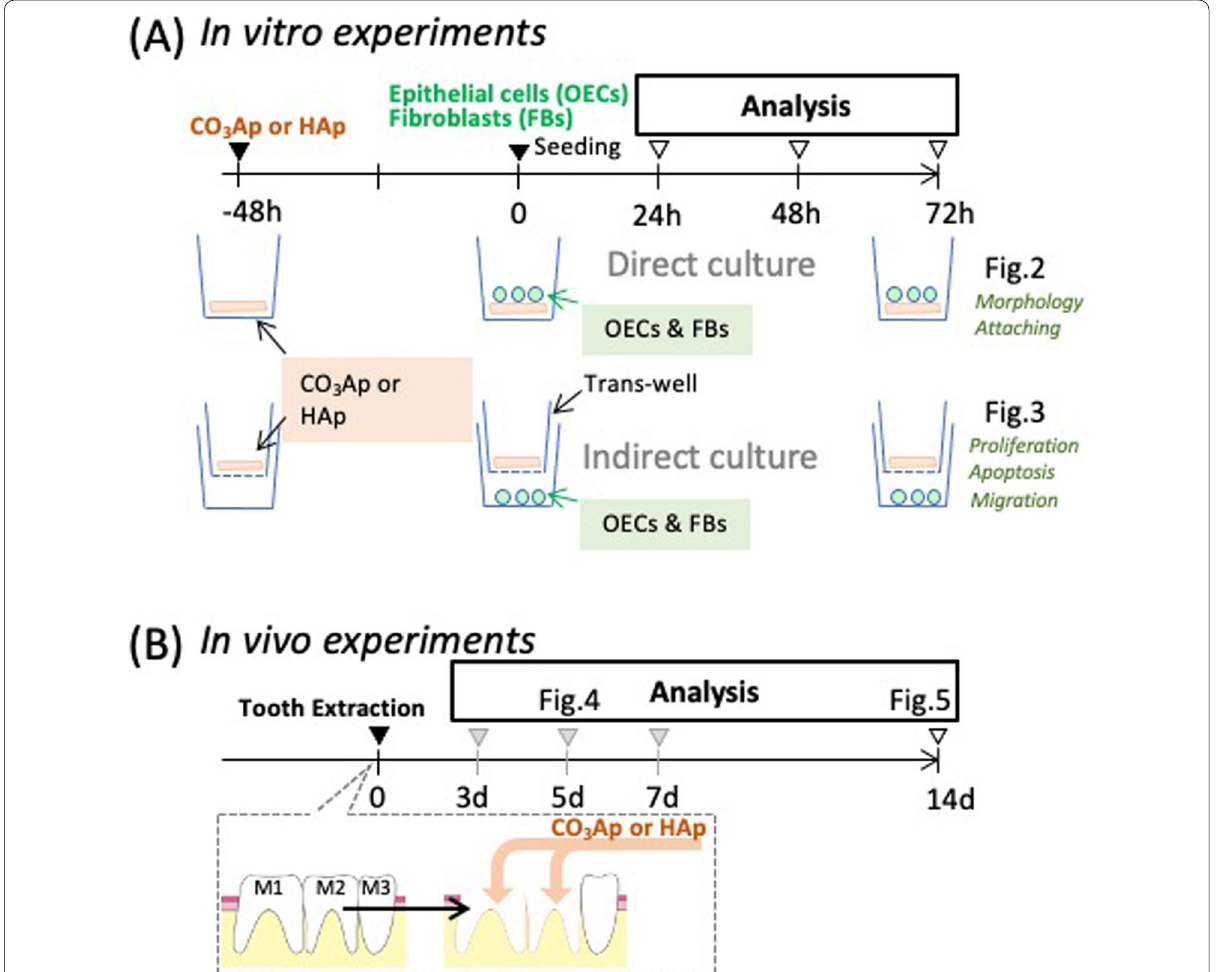
Fig. 1 In vivo and in vitro experimental design. A The experimental protocol of the in vitro study. The upper stage showed that OECs or FBs were cultured directly on the material (CO 3 Ap or HAp). In the lower stage, the material was placed in the Transwell and each cell was indirectly cultured. B The experimental protocol for the in vivo study. Bone substitute (CO 3 Ap or HAp) filling was performed immediately after tooth extraction (M1 and M2) and the healing of soft tissues was observed over